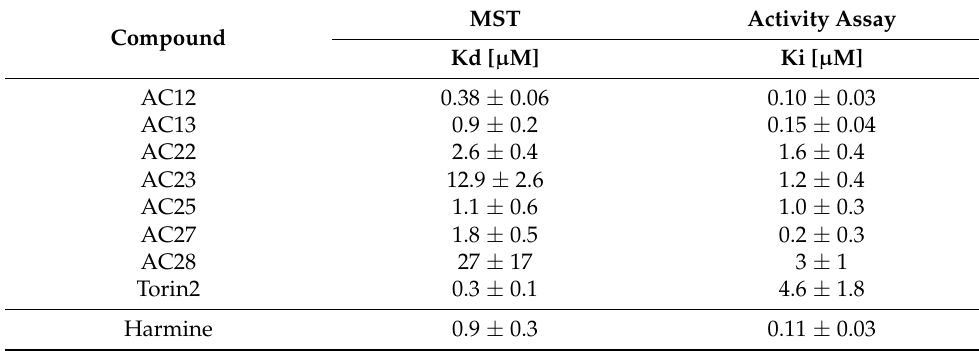
Table 1. The dissociation constant (Kd) and inhibitory constant (Ki) values determined for the studied compounds and DYRK1A in MST and Cook assays, respectively.